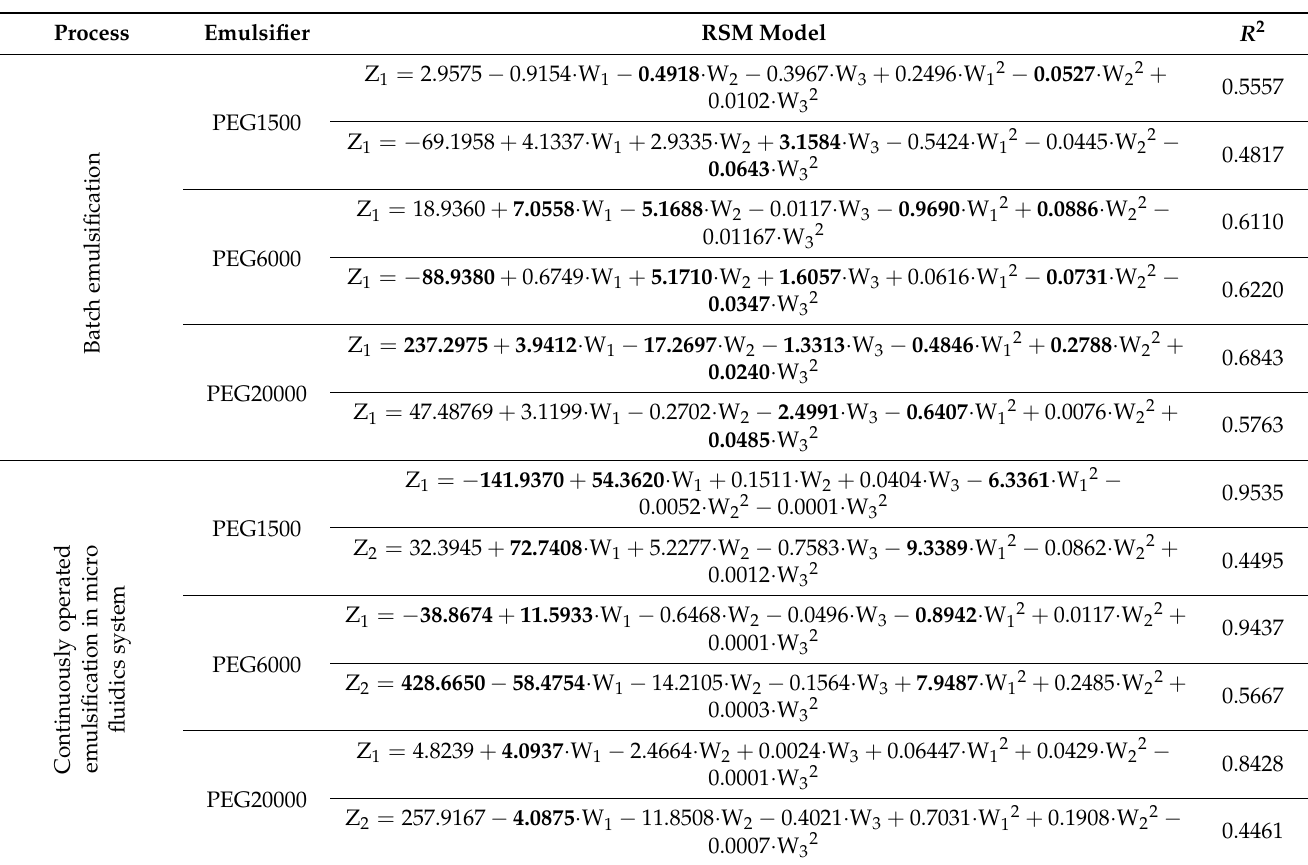
Table 5. RSM models for description of zeta potential (1st row of a given emulsifier) and average Feret diameter of droplets (2nd row of a given emulsifier). For batch experiments X 1 stands with emulsifier concentration, X 2 for oil concentration and X 3 for mixing rate. In microfluidic experiments W 1 stands with emulsifier concentration, W 2 with oil concentration and W 3 with total flow rate. Significant coefficients of the RSM model are shown in